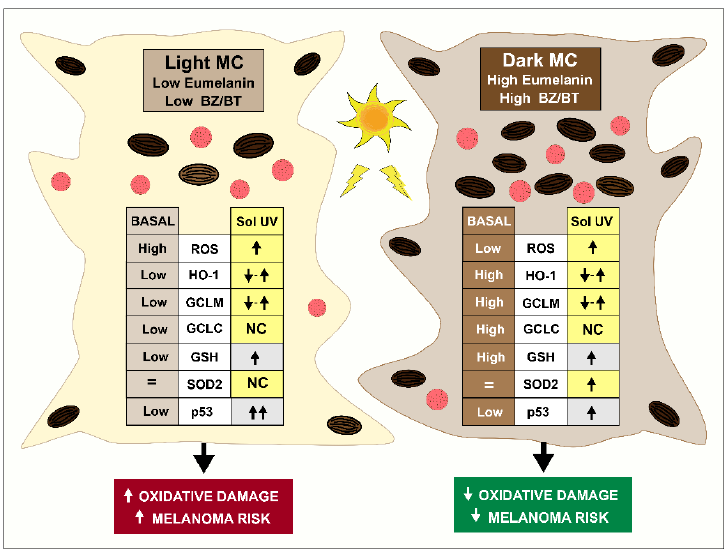
Figure 7. Summary of the observed differences between light and dark melanocytes (MC) that account for the increased oxidative damage and melanoma risk in individuals with light skin. Light melanocytes have higher basal and solar UV-induced levels of ROS and express lower basal levels of the antioxidant enzymes HO-1, GCLM, and GCLC than dark melanocytes. Due to the differences in the GCLM and GCLC levels, the GSH levels are lower in light than in dark melanocytes. In response to solar UV, the levels of HO-1 and GCLM are initially reduced at 6 h but then rebound at 24 h post- irradiation. Following the solar UV exposure, no change in the levels of GCLC was observed following solar UV exposure, and the levels of SOD2 were only increased in dark melanocytes. The solar UV- induced increase in p53 and lipid peroxidation, indicative of oxidative damage, were markedly greater in light, as compared to dark, melanocytes. ↑ = increase; ↓ =decrease; MC,